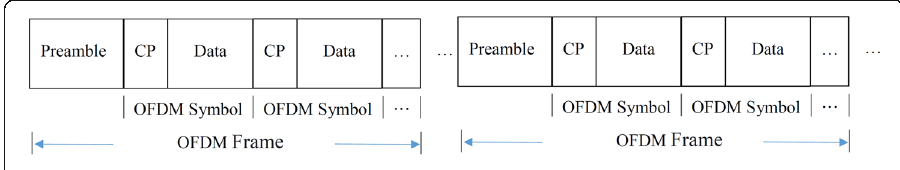
Fig. 2 Each transmitter structure of preamble MIMO-OFDM